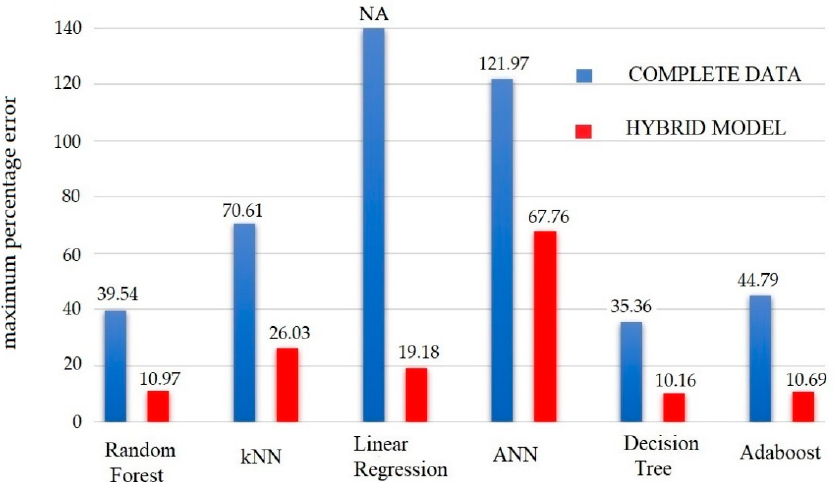
Figure 10. Comparison of the maximum percentage error in the prediction of M/E power with the complete data set and the hybrid model.